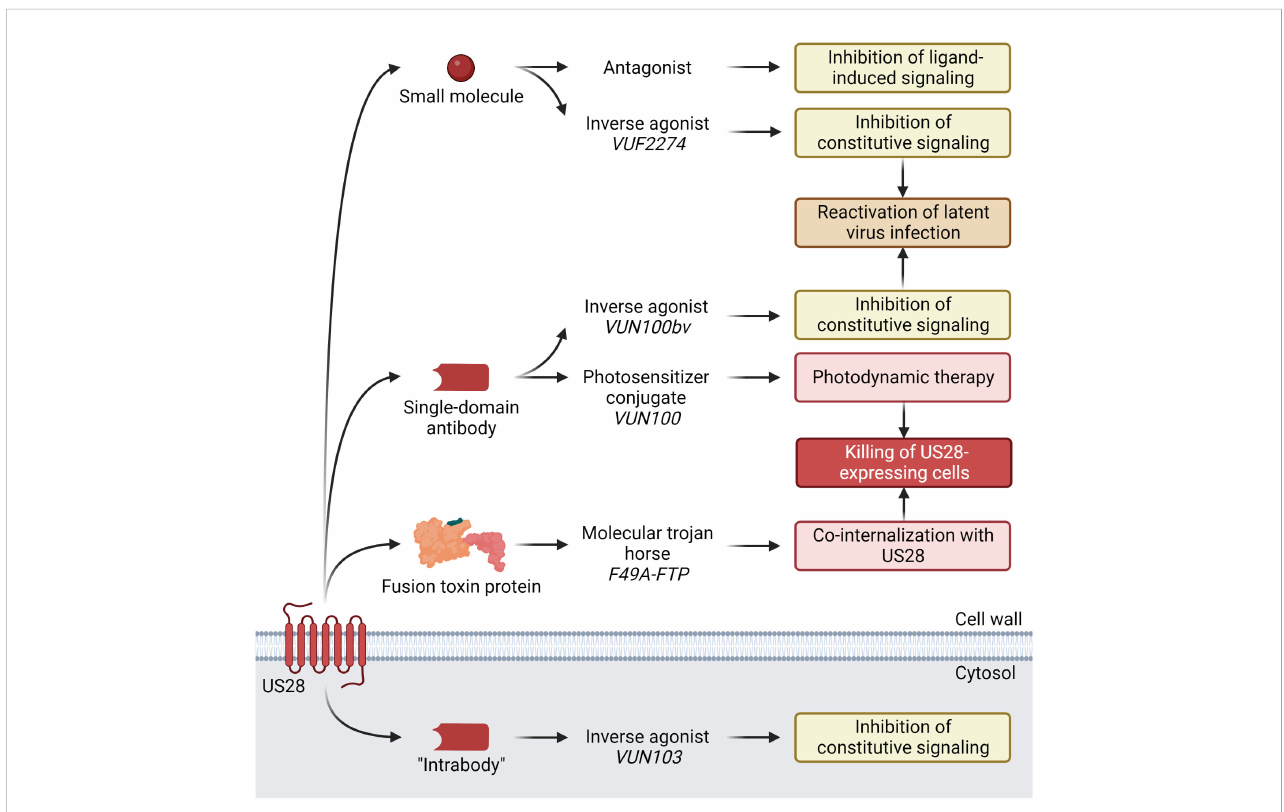
FIGURE 1 Current anti-HCMV US28-targeting modalities under development, discovered compounds, and their demonstrated effects. Small molecule VUF2274 and sdAb VUN100bv act as inverse agonists, i.e. inhibitors of US28 constitutive signaling. Attenuation of US28 signaling results in activation of the major immediate early promotor (MIEP), which leads to HCMV reactivation from latency. Another sdAb, VUN100, in conjugation with a photosensitizer binds to US28 on the surface of HCMV-infected cells. Upon stimulation with near-infrared light, the sdAb-photosensitizer conjugate is activated, producing reactive oxygen species that cause cell death. F49A-FTP consists of a US28-speci fi c chemokine domain and a Pseudomonas exotoxin A (PE) domain that are fused. Upon binding to US28, it is co-internalized with the receptor. Inside the HCMV infected US28-expressing cell, the PE domain is released by furin cleavage. PE inactivates the eukaryotic elongation factor-2 (eEF-2), which halts host cell protein synthesis, resulting in apoptosis and cell death.